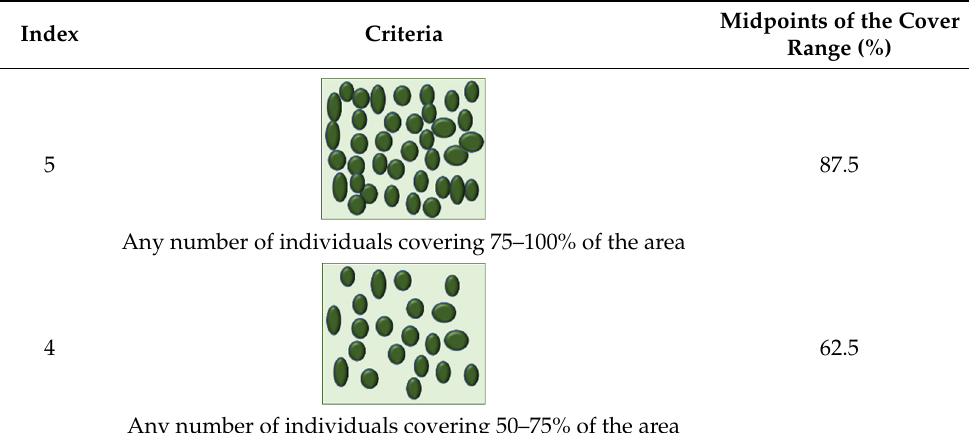
Table 3. Criteria for assigning the discrete Cover-Abundance Index and the relative midpoints used for their transformation.